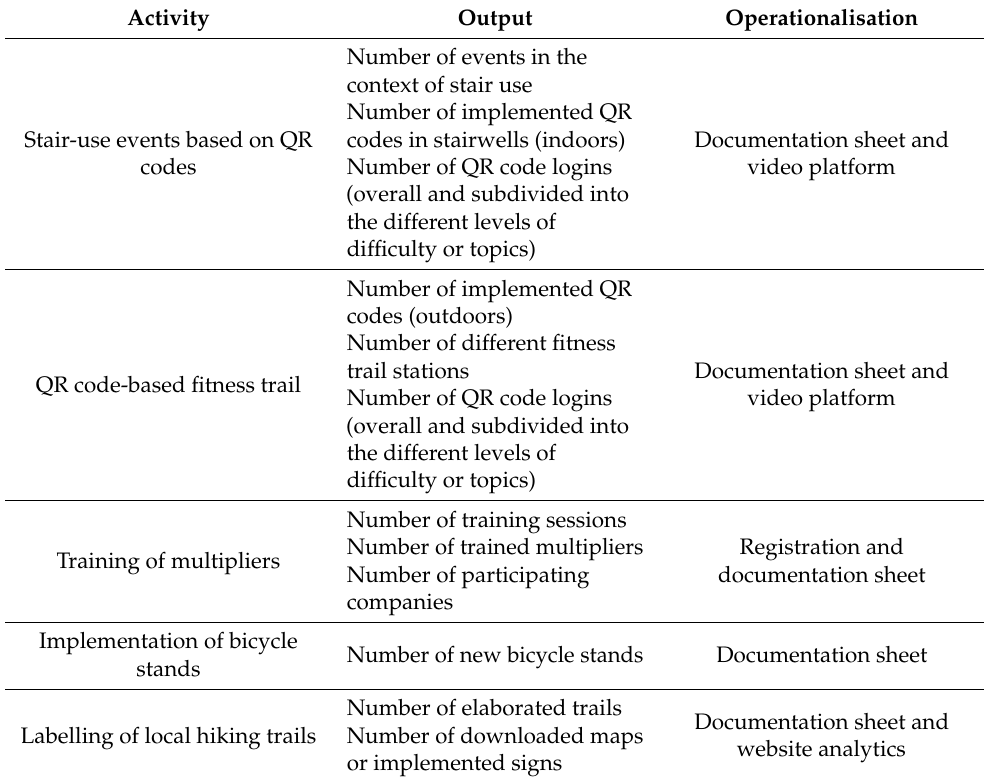
Table 2. Output and operationalisation of specific environmental measures of the KomRueBer study.